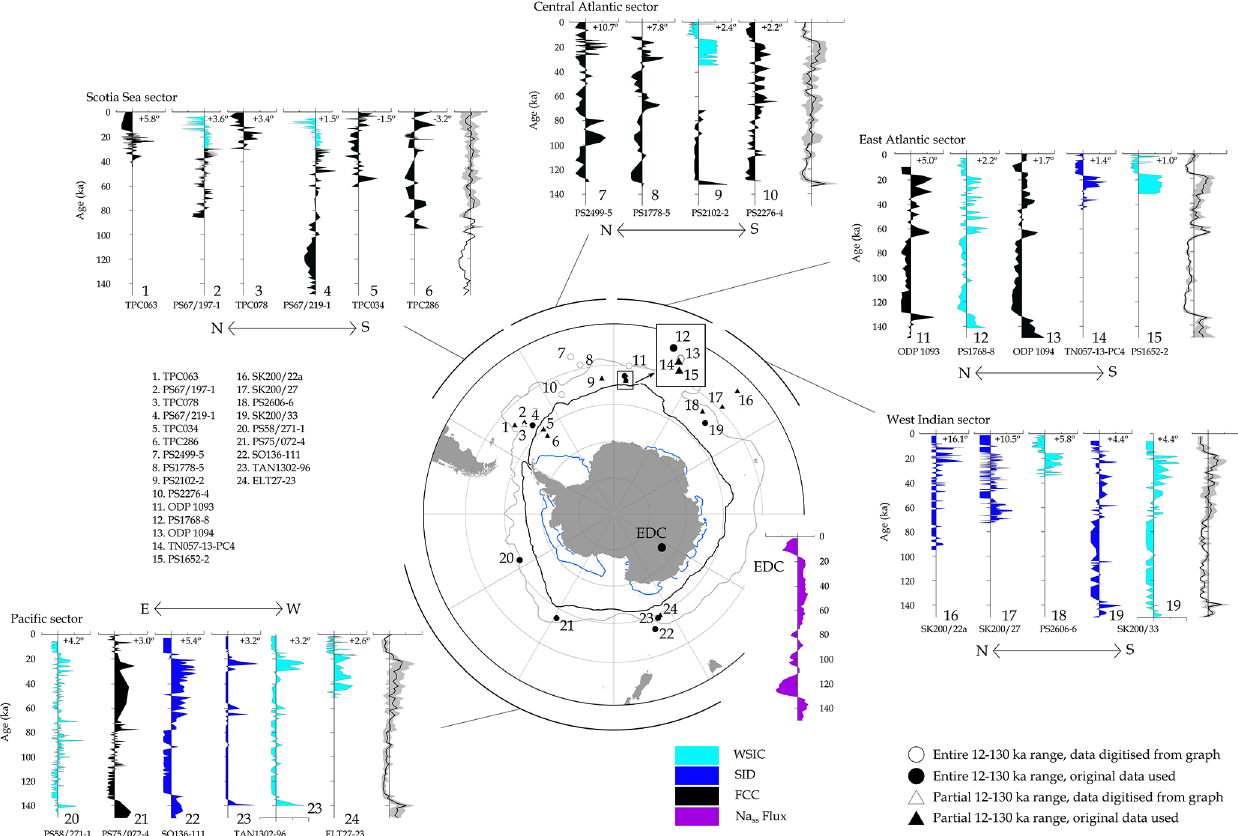
Figure 2. Normalised FCC (combined relative abundance of F. curta and F. cylindrus ), WSIC (winter sea-ice concentration) and SID (sea- ice duration) records from Southern Ocean marine sediment cores and the Na ss flux record from the EDC ice core shown alongside a map of Antarctica with core locations, modern February (blue line) and September (black line) sea-ice extents (data from Fetterer et al., 2017) and the modern Antarctic Polar Front position (grey line; Trathan et al., 2000). Downcore records are arranged together in Southern Ocean regions, with distance from the modern winter sea-ice (WSI) edge given in degrees latitude (plus sign indicates locations north of the mean WSI edge, minus sign indicates locations south of the mean WSI edge). Each region also has a stacked record with the mean (black line) and interquartile range (grey shading)